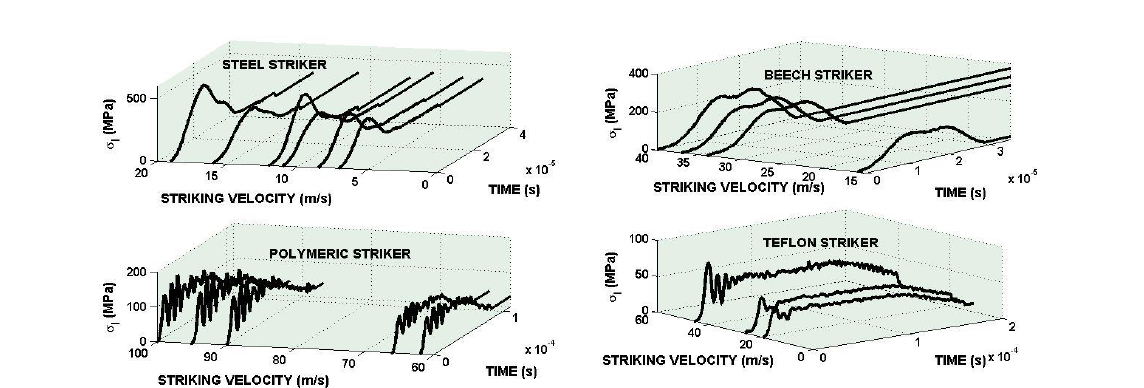
Fig.2 . Examples of the input stress pulses,  I produced by different strikers.